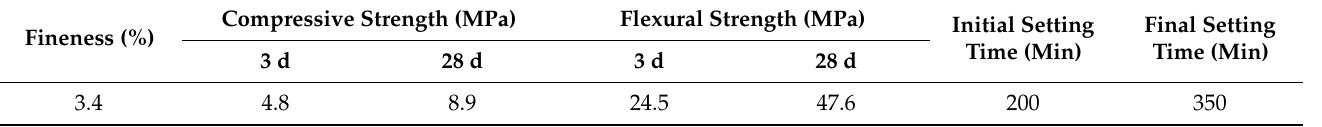
Table 2. Basic physical performance indexes of P.O32.5